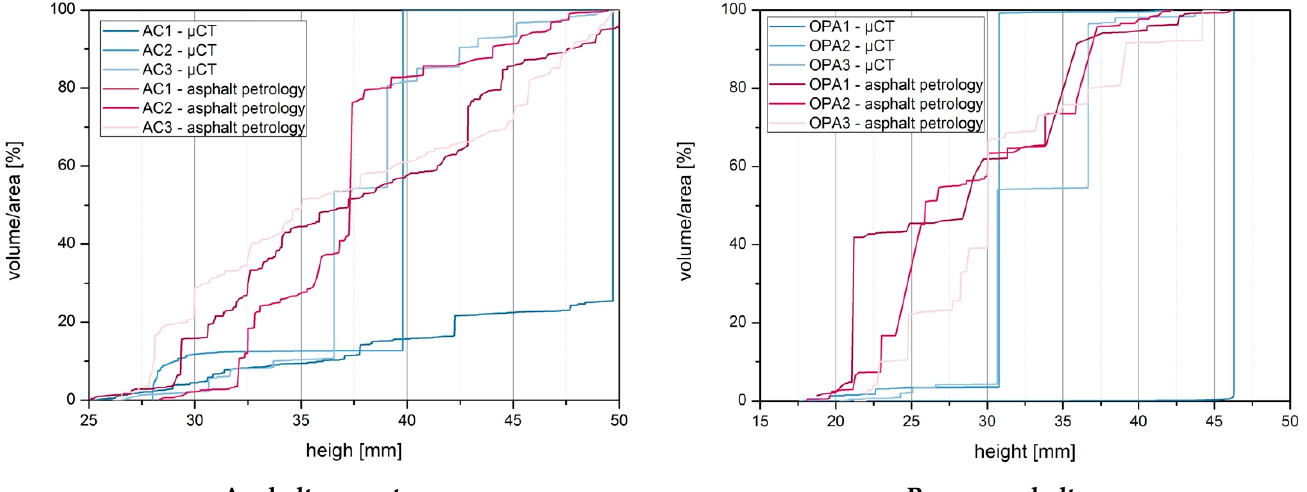
Figure 13. Comparison of height and volume/area (2D method (asphalt petrology) and 3D method (µ-CT)). ( µ